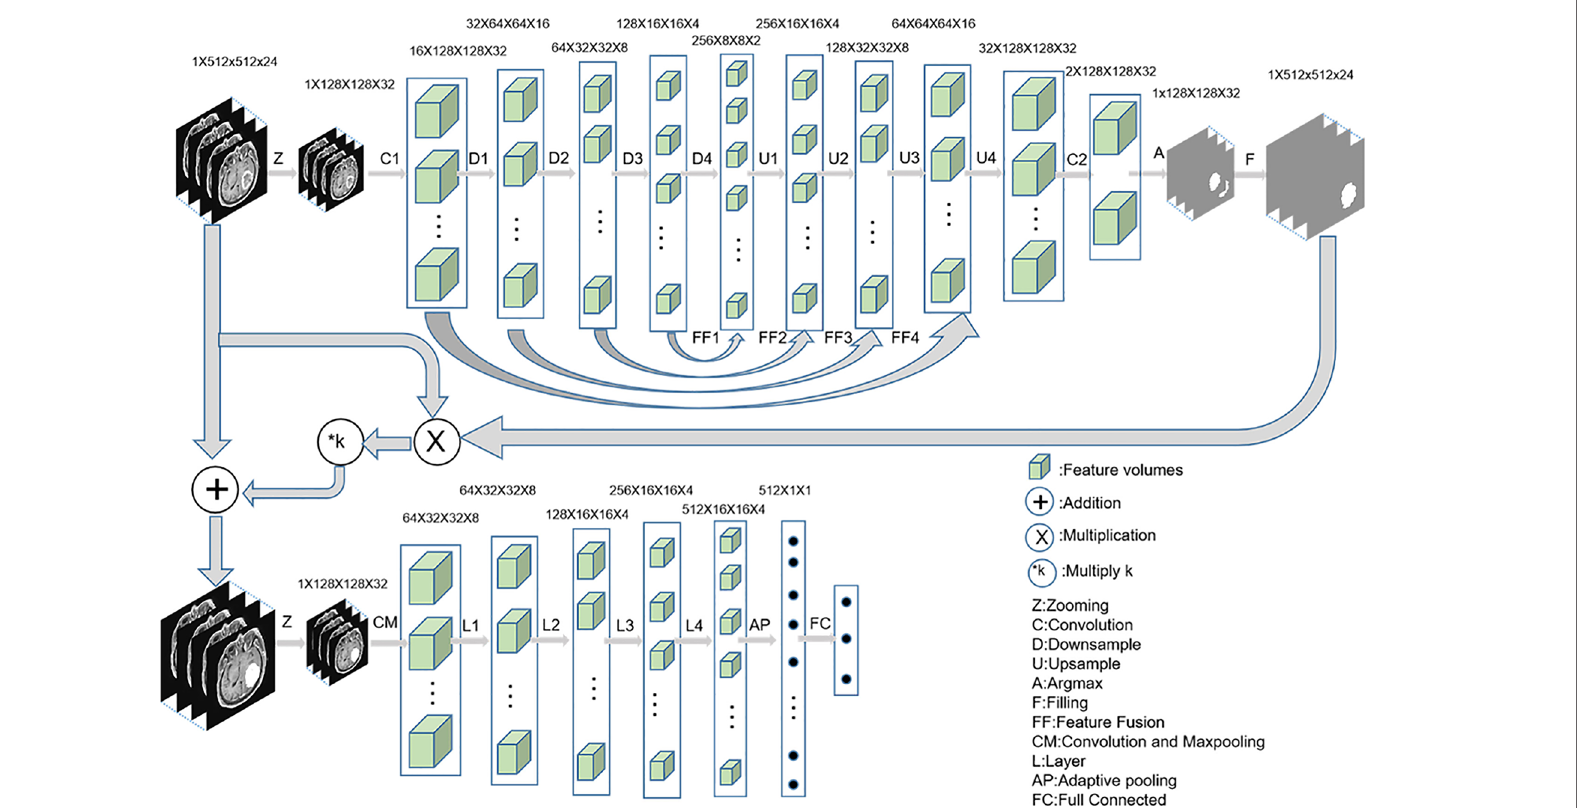
FIGURE 1 | The implementation process of three-stage algorithm based on deep learning with data enhancement. In the fi rst stage, 3D u-net is used to capture the lesion area; in the second stage, enhanced data are generated; and in the third stage, 3D Resnet is used for